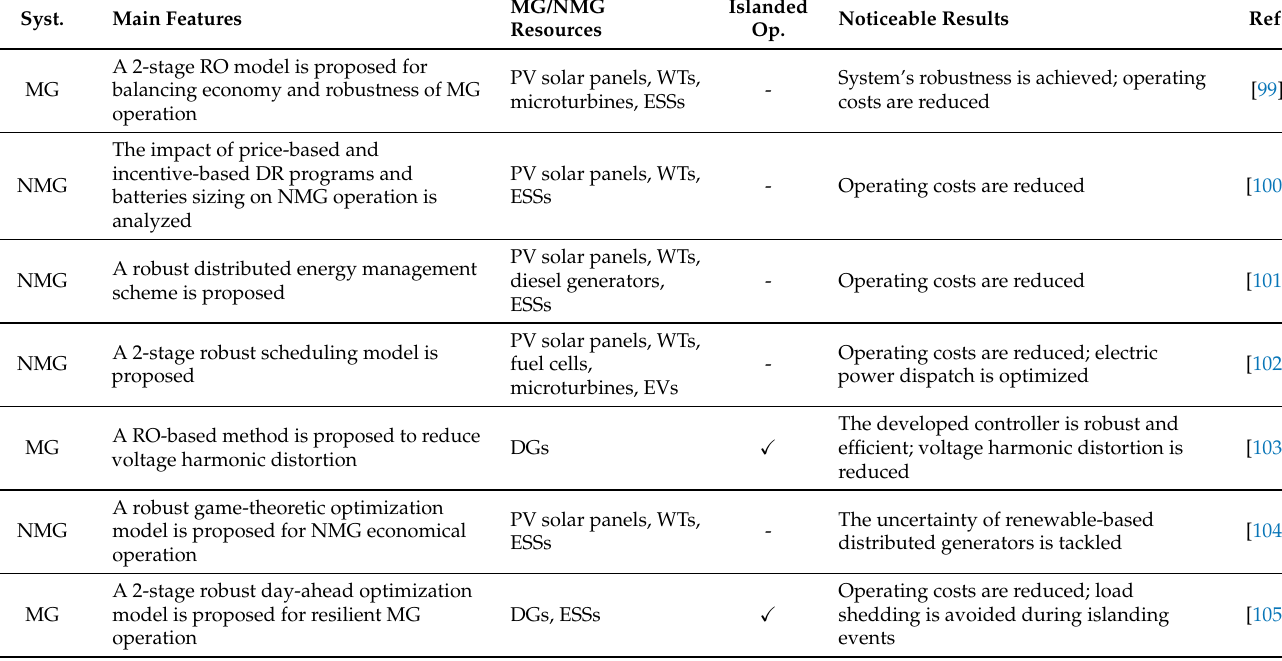
Table 7. A focus on papers dealing with robust optimization (RO) for MG/NMG management. DG stands for distributed generator. DR stands for demand response. ESS stands for energy storage system. MG stands for microgrid. NMG stands for networked microgrid. WT stands for wind